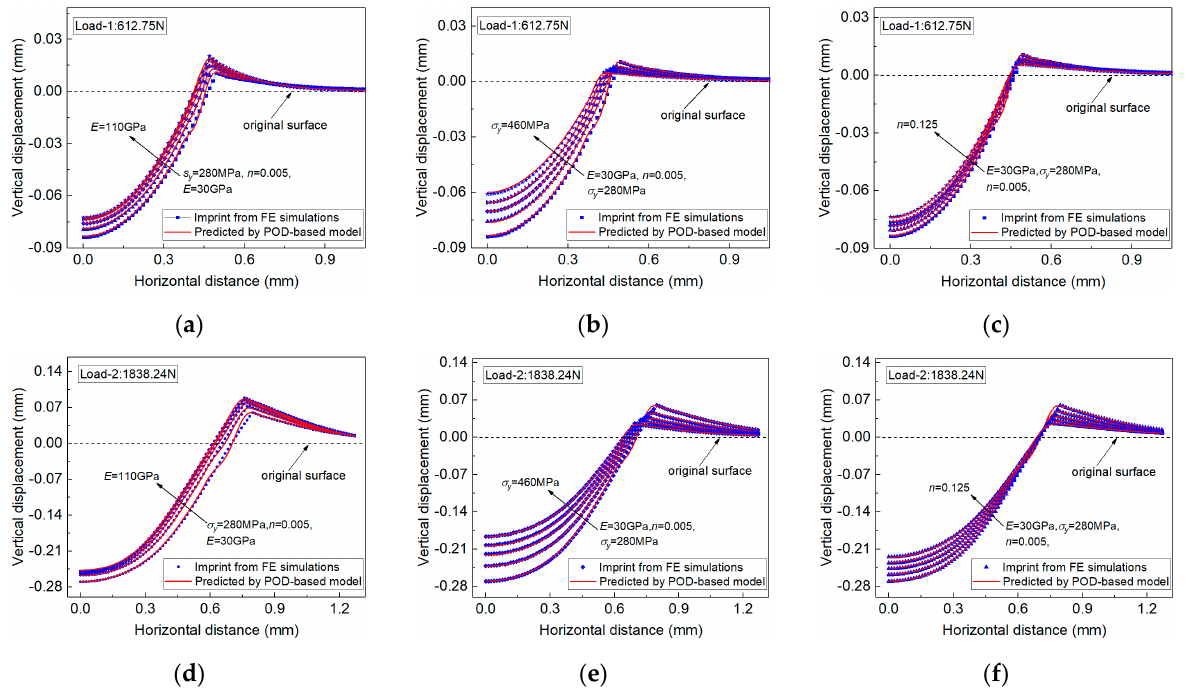
Figure A1. Comparison of the indentation imprints between the FE simulation and those calculated using the parametric relationship in Equation (7): in ( a , b , c ) for indentation Load-1, and in ( d , e , f ) for indentation Load-2. Thus, the parametric process obeys the relation: 𝛽 (cid:3036)(cid:3037) (cid:3435)𝑐 (cid:3037) (cid:3439) = 𝑝 (cid:3021) (cid:3435)𝑐 (cid:3037) (cid:3439) ⋅ 𝑎 (cid:3036)(cid:3037) . Here, the polyno-